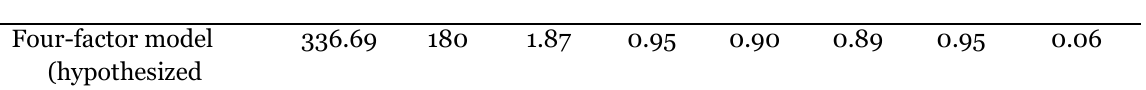
CFA-Model Fit Indices for Study Variables Measurement